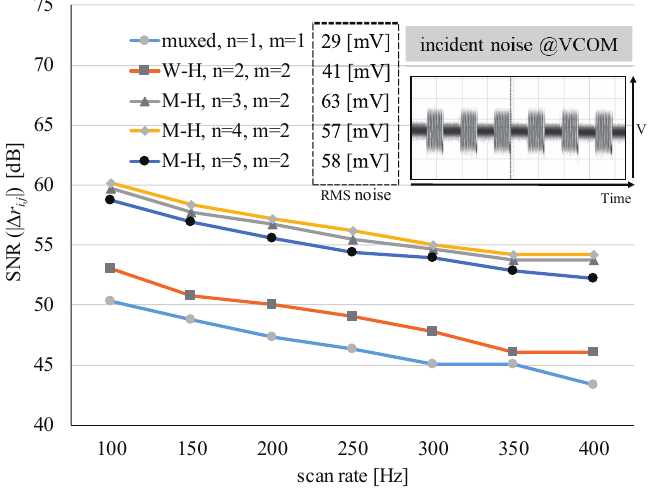
Figure 11. Changes in the SNR according to the scan rate and the interference level.